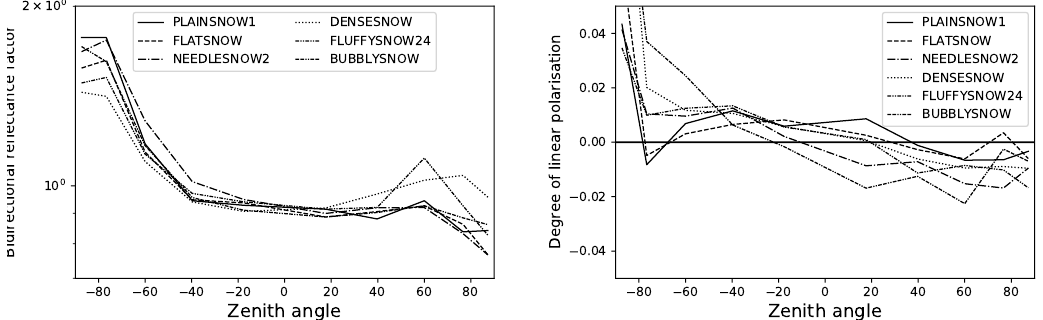
Figure 2. The modelled bidirectional reflectance factor (BRF, left) and the degree of linear polarisation (DQP, right) of several snow types in the principal plane as a function of observation zenith angle at a 60 ◦ solar zenith angle and and a wavelength of 550 nm.‘ Plane snow” is 20% dense, with randomly oriented ellipsoidal grains (semiaxii 0.4, 0.5, 0.69 mm) with a rough surface ( σ = 0 . 01 , ρ = 0 . 1 ), 64 cm thick layer. In “Flat snow’,’ grains are oriented on the flat side. “Needle snow” is more elongated. “Dense snow” is 40% dense. “Fluffy snow” contains small ripples of hoar on the surface. “Bubbly snow” contains small air bubbles inside.